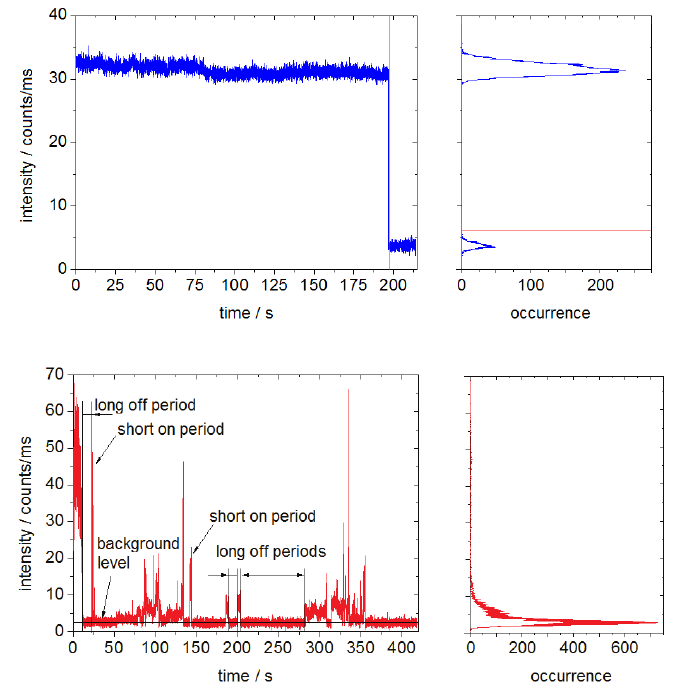
Figure 9. Examples of fluorescence time traces of 1 in pvac recorded at (a) 21°C and (b)